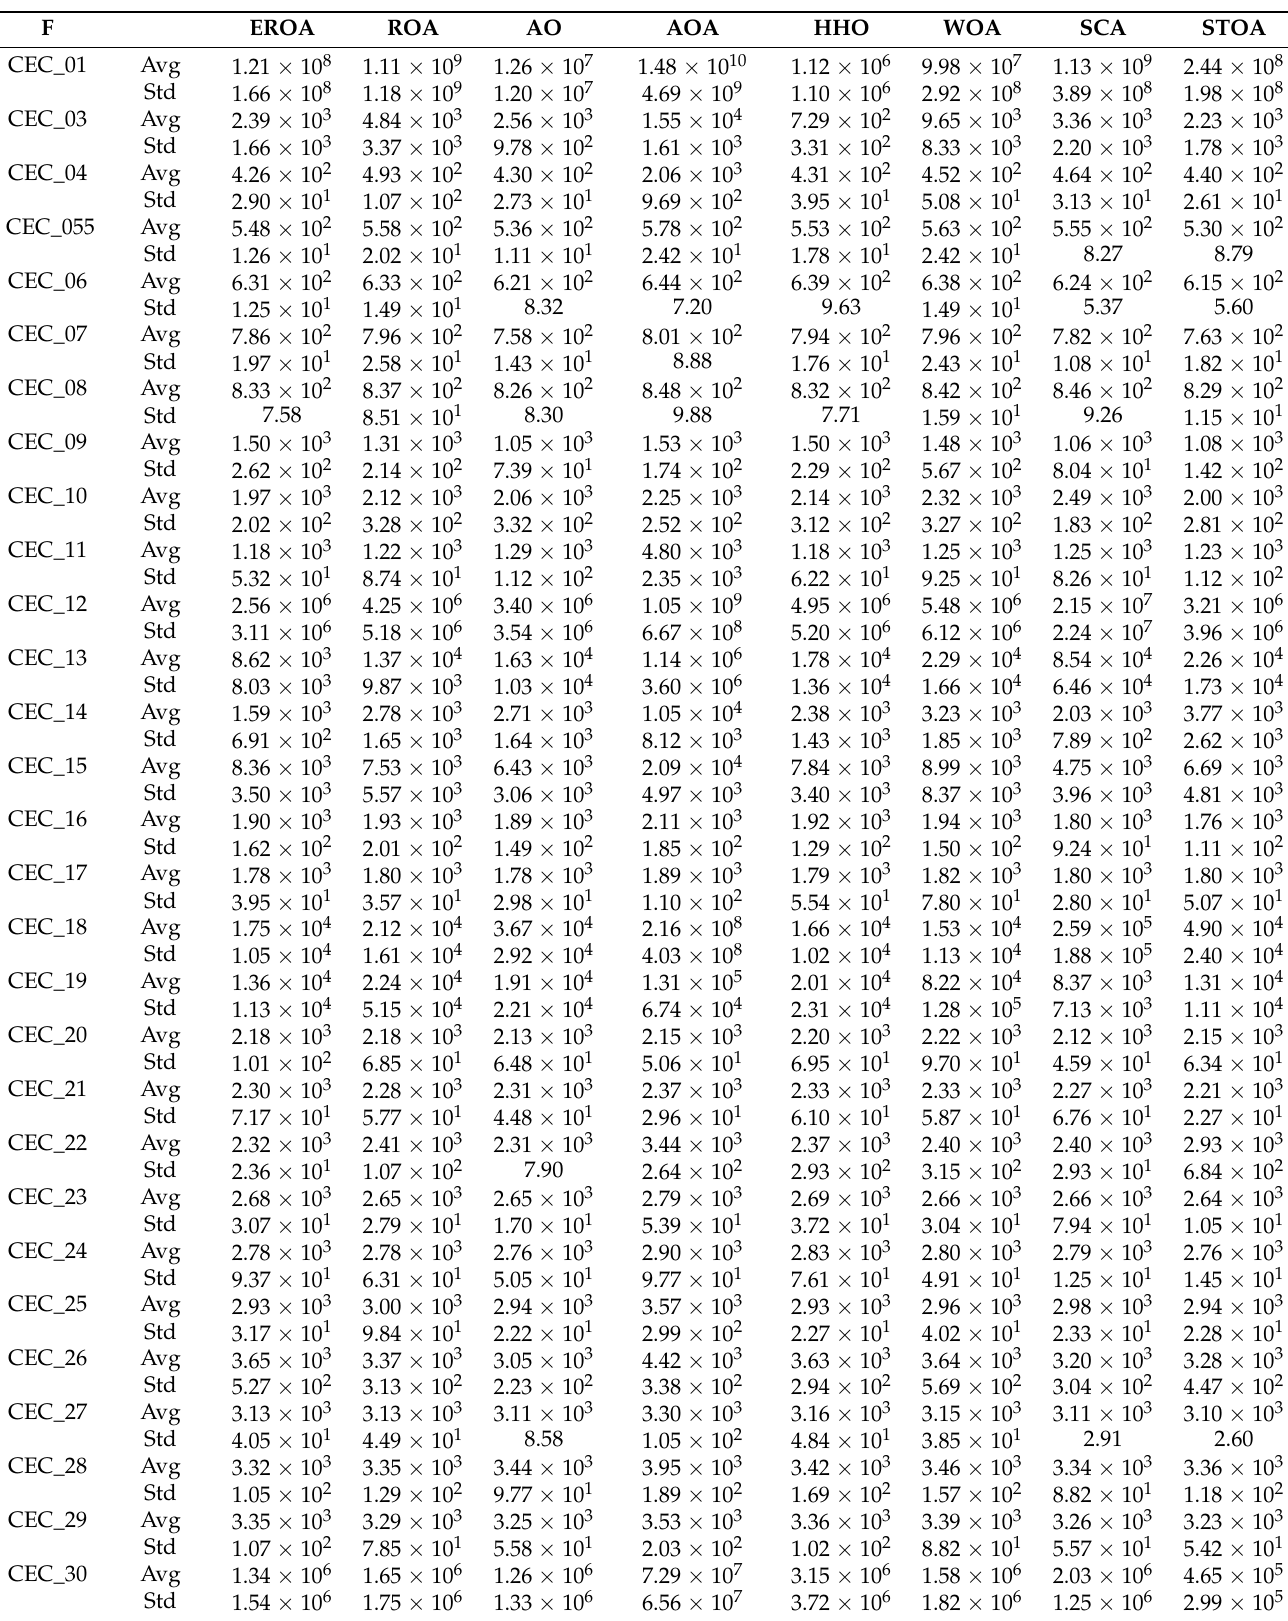
Table 7. Results of algorithms on the CEC2017 test